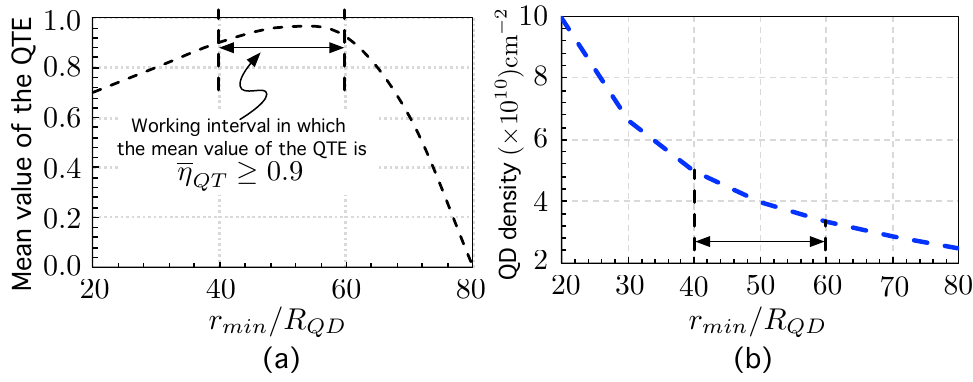
Figure 4. ( a ) Mean value (over 50 networks) of the quantum transport efficiency (QTE) as a function of the minimum inter-dot distance normalized by R QD , r min / R QD . ( b ) QD density ( a function of r min / R QD